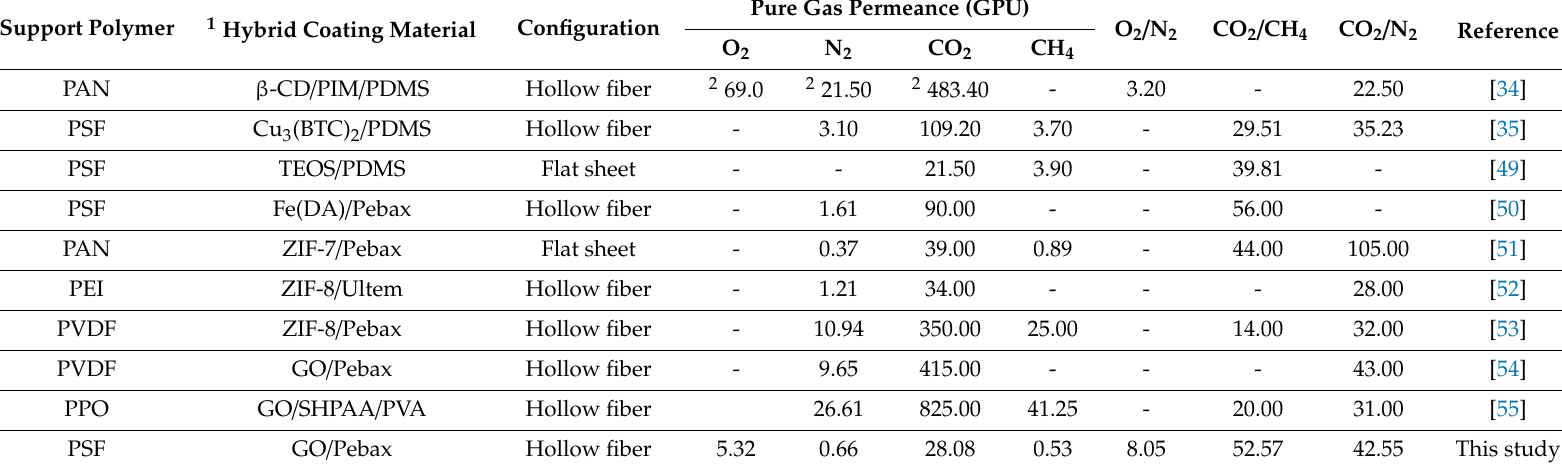
Table 1. Comparison of membranes with a hybrid coating layer for gas